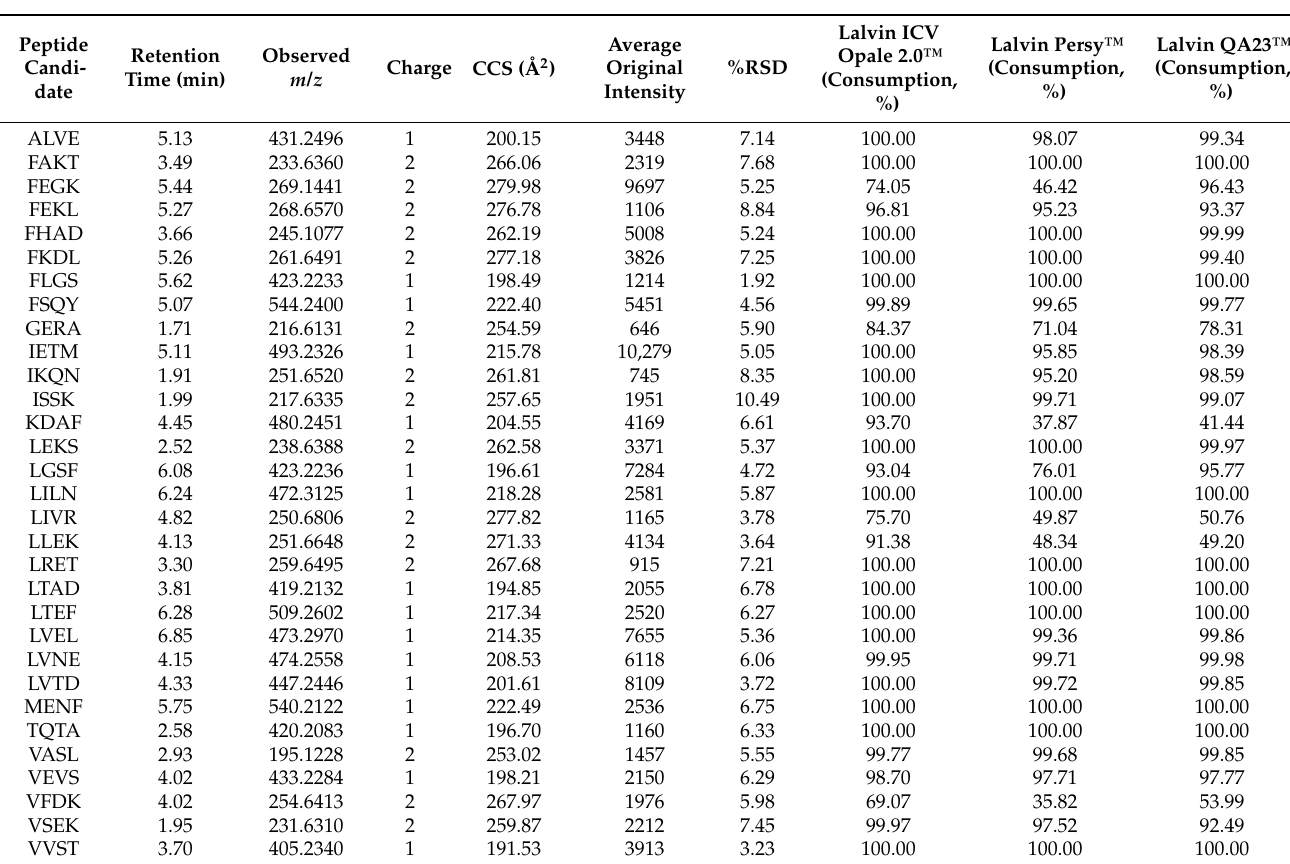
Table A6. The proposed tetrapeptide sequences and observed relative consumption during fermenta- tion with Lalvin ICV Opale 2.0™, Lalvin Persy™ and Lalvin QA23™ of the modified synthetic must. Peptide sequences were acquired by peptide mapping to bovine serum albumin protein sequence (UniProtKB–P02769 (ALBU_BOVIN)). Additionally presented are the retention time, observed m/z , collision cross section values, as well as the averaged peptide intensities at the starting point and associated relative standard